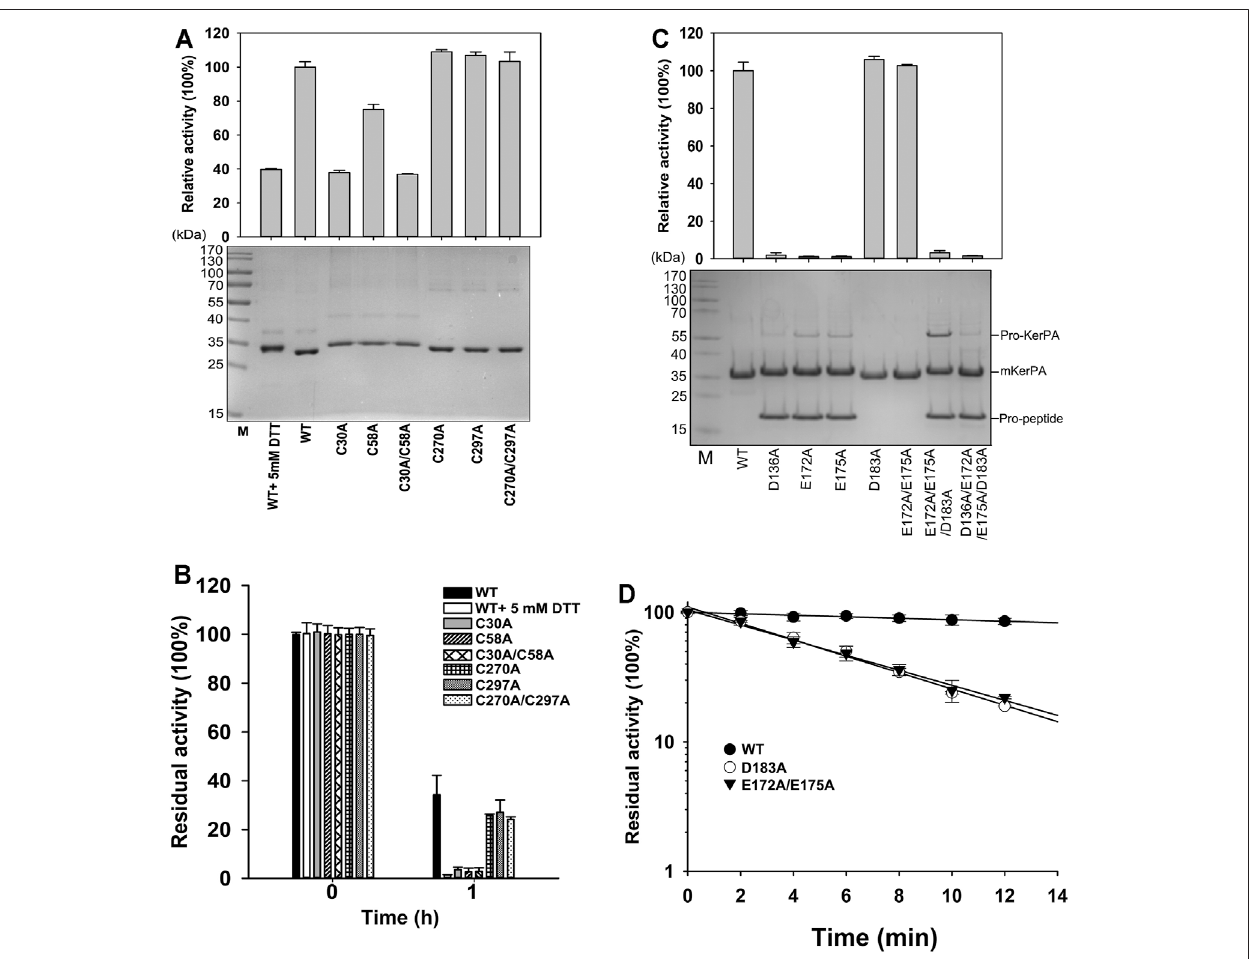
FIGURE 3 | Properties of disulphide bonds and Ca 2+ binding related variants. (A) Activity assays ( upper ) and SDS-PAGE analysis ( lower ) of puri fi ed samples of variant enzymes and wild-type (WT) with or without 5 mM DL-dithiothreitol. Activity was assayed at 55 ° C in Phosphate Buffer (PB) using azocasein as substrate, and relative activity was calculated by de fi ning activity of WT without 5 mM DL-dithiothreitol as 100%. (B) Thermostabilities of variants and WT with or without 5 mM DL- dithiothreitol. Puri fi ed samples in PB were incubated at 65 ° C for 1 h, and residual activities were determined using azocasein as substrate. (C) Activity assays ( upper ) and SDS-PAGE analysis ( lower ) of puri fi ed samples of variant enzymes. Azocaseinolytic activity was assayed at 55 ° C in PB. Proform of keratinase from Pseudomonasaeruginosa (KerPA),matureenzyme,andpropeptideinproteinsamplesareshownongel. (D) Heatinactivationpro fi lesofvariants.Enzymesampleswere incubated at 65 ° C for indicated times, and residual activity was assayed using azocasein as substrate at 55 ° C. Values are means ± Standard Deviation (SD) of three independent experiments.